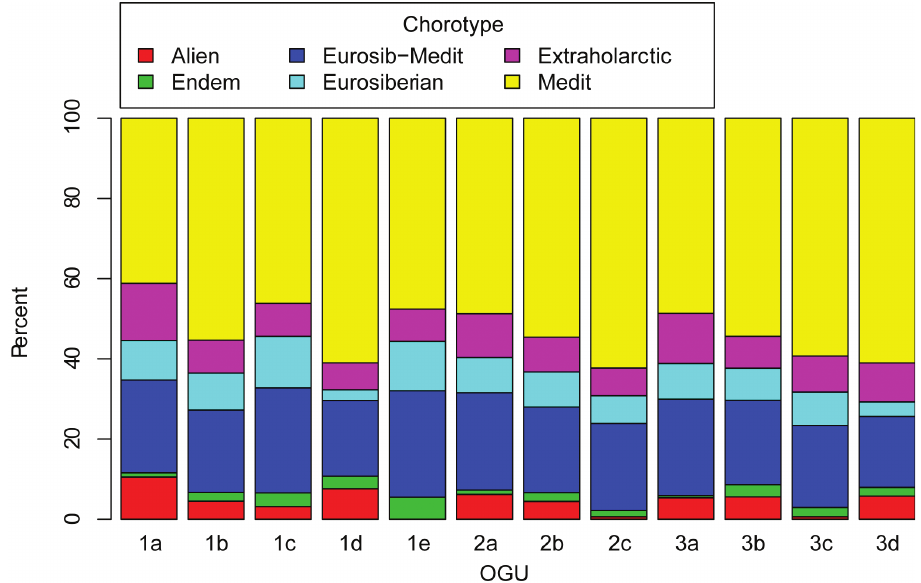
Figure 3. Chorological spectra for each Operational Geographic Unit. Alien = alien species, Endem = Italian endemic species, Extraholarctic = species showing range larger than Holarctic floristic kingdom, Eurosiberian = species showing range within the Eurosiberian floristic region, Eurosib-Medit = species showing range across Eurosiberian and Mediterranean floristic regions, Medit = species showing range within the Mediterranean floristic